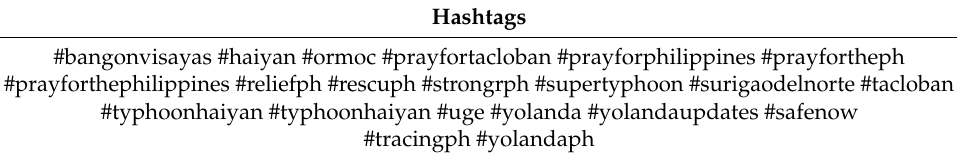
Table A1. Hashtags related to typhoon